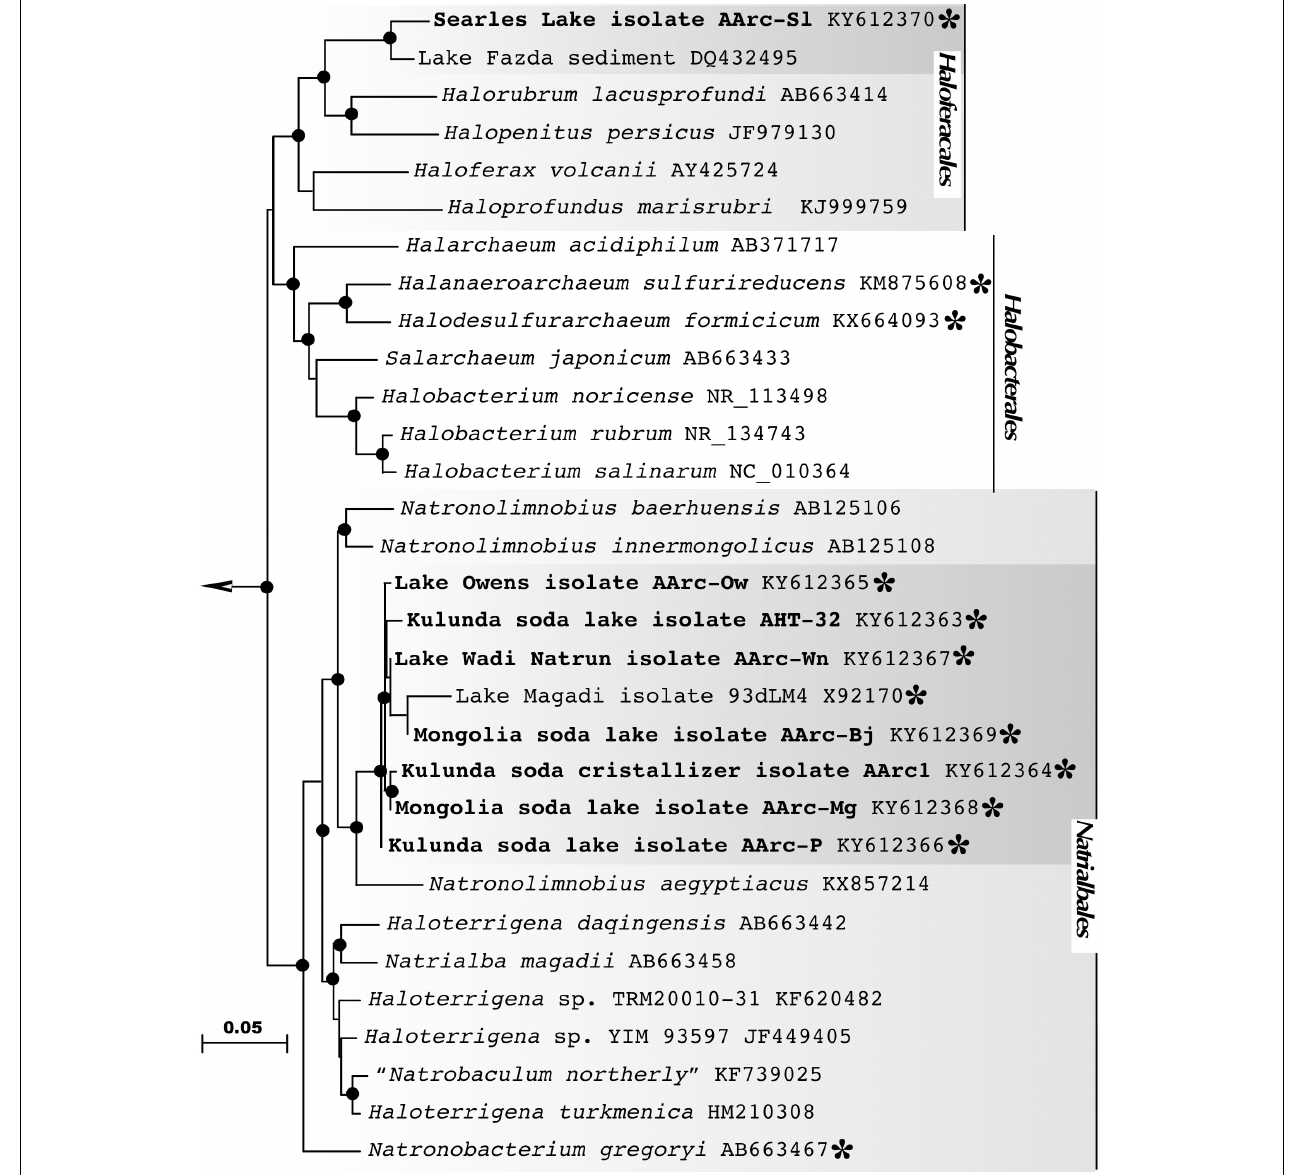
FIGURE 2 | 16S rRNA gene-based Maximum Likelihood phylogenetic tree showing the position of the sulfur-reducing natronoarchaea isolates (highlighted in bold) within the orders Haloferacales and Natrialbales . Members of the class Halobacteria, with experimentally confirmed ability for sulfur respiration, are highlighted by asterisks. Filled circles at the nodes indicate the bootstrap values > 70% (1000 bootstrap iterations). Methanohalophilus halophilus DSM 3094 T (GenBank accession no. FN870068) was used as an outgroup. Bar represents 0.05 substitutions per nucleotide